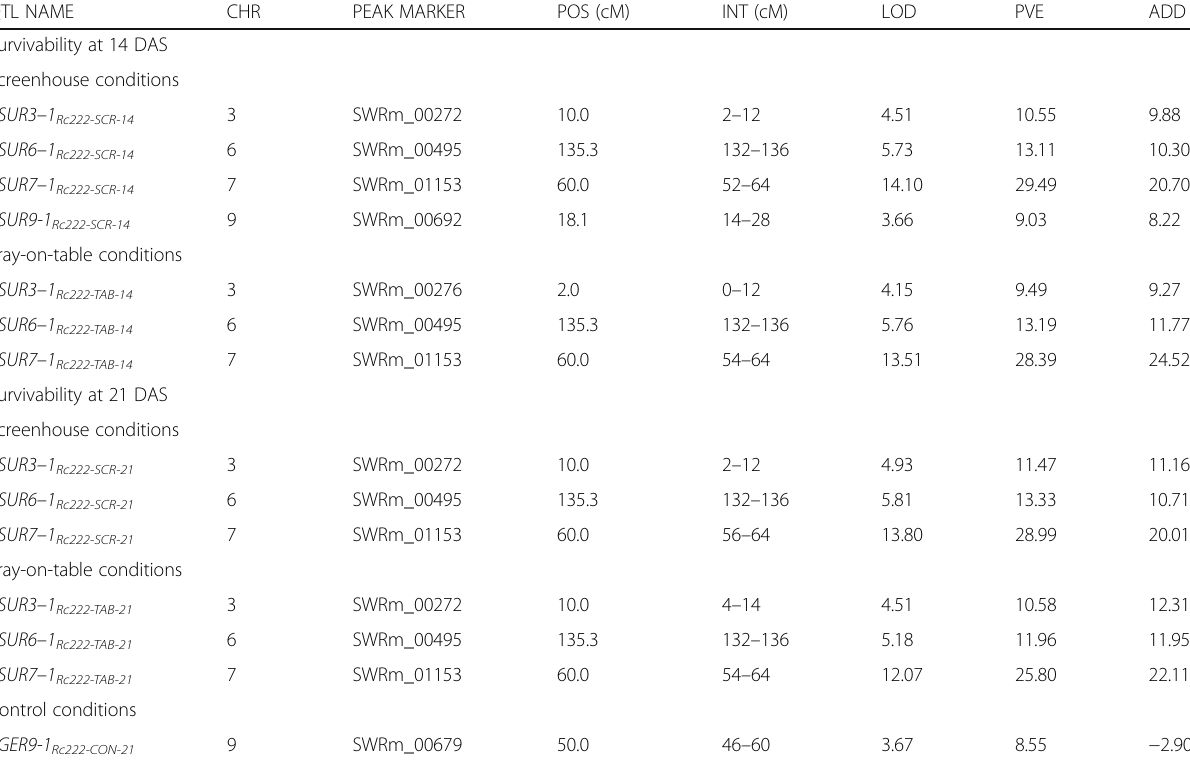
Table 3 List of QTLs Detected for Anaerobic Germination Potential in the BC 1 F 2:3 Population of Kalarata and NSIC